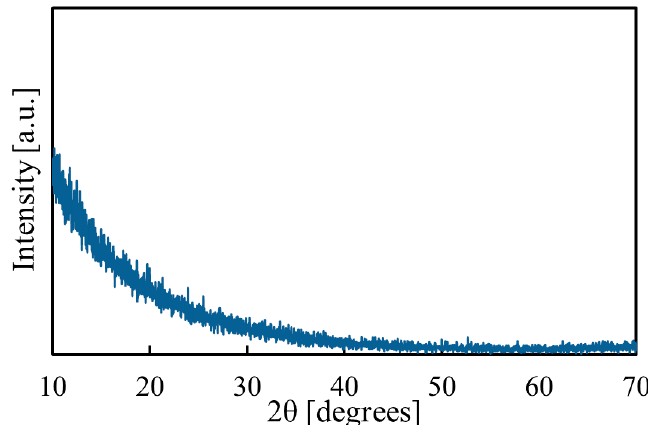
Figure 9. XRD of the Mg(OH) 2 film.